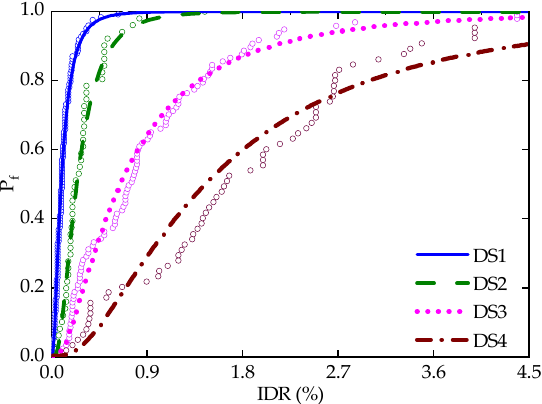
Figure 3. Proposed fragility function curves for infill panels. Table 5. Seismic performance target and statistical parameters.